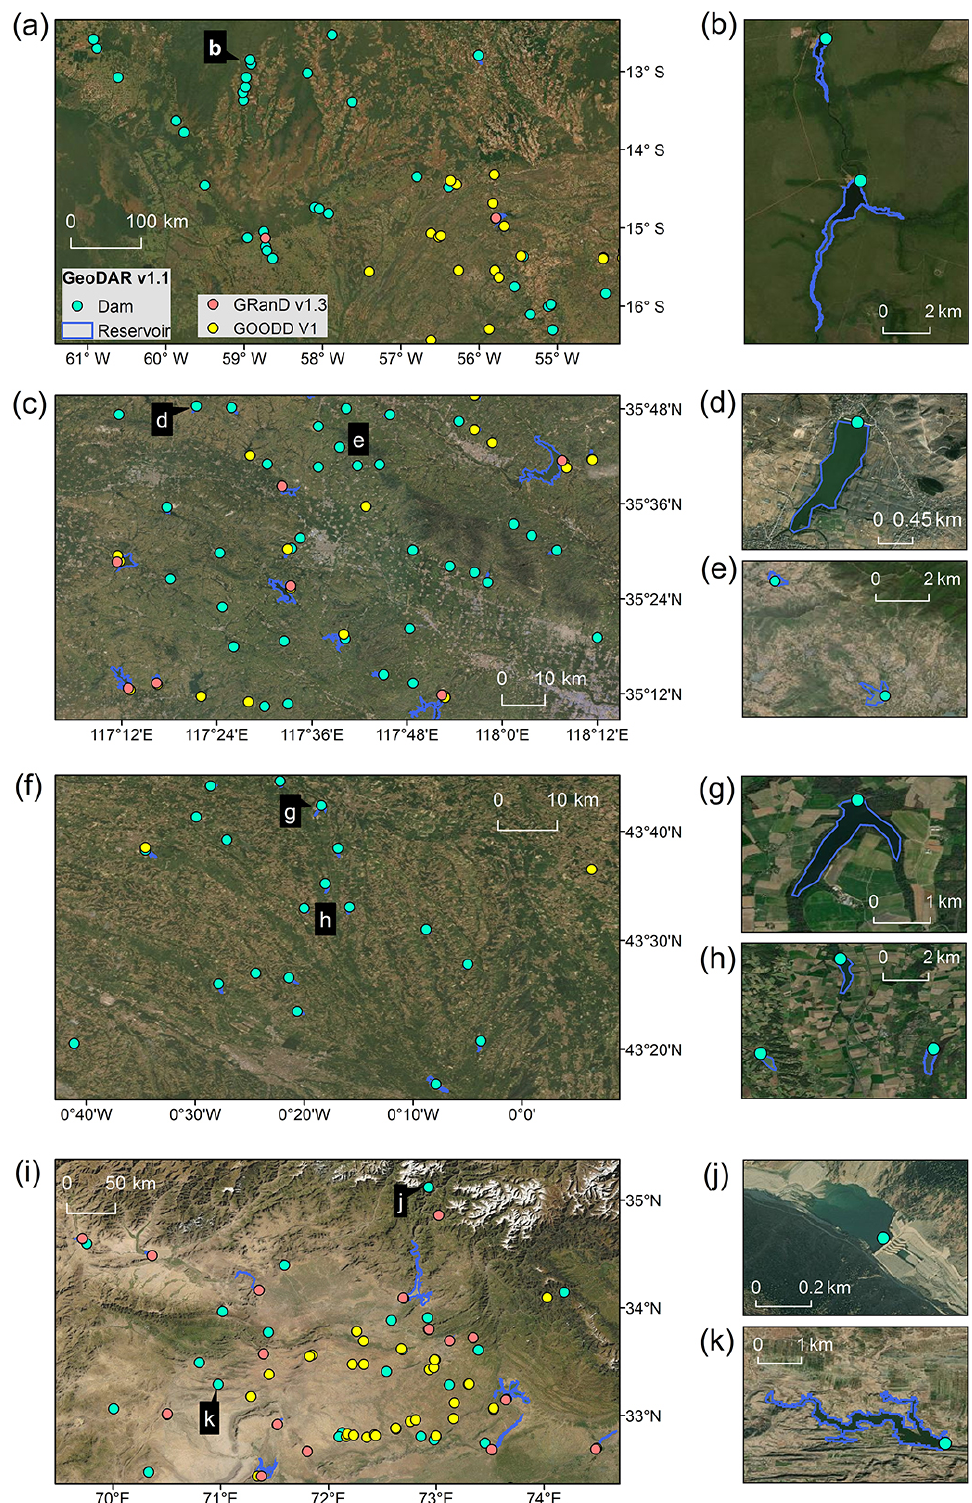
Figure 16. Comparisons between GRanD v1.3, GOODD V1, and GeoDAR v1.1 in selected regions of the world. (a–b) Cerrado, Brazil (Mato Grosso State). (c–e) Northern China (Shandong Province). (f–h) Southwestern France (Aquitaine and Midi-Pyrenees). (i–k) Northern Pakistan (northern highlands and foothills). GRanD points (red) are placed on top of GOODD (green), which is placed on top of GeoDAR (yellow). Background image source: Esri imagery base map.